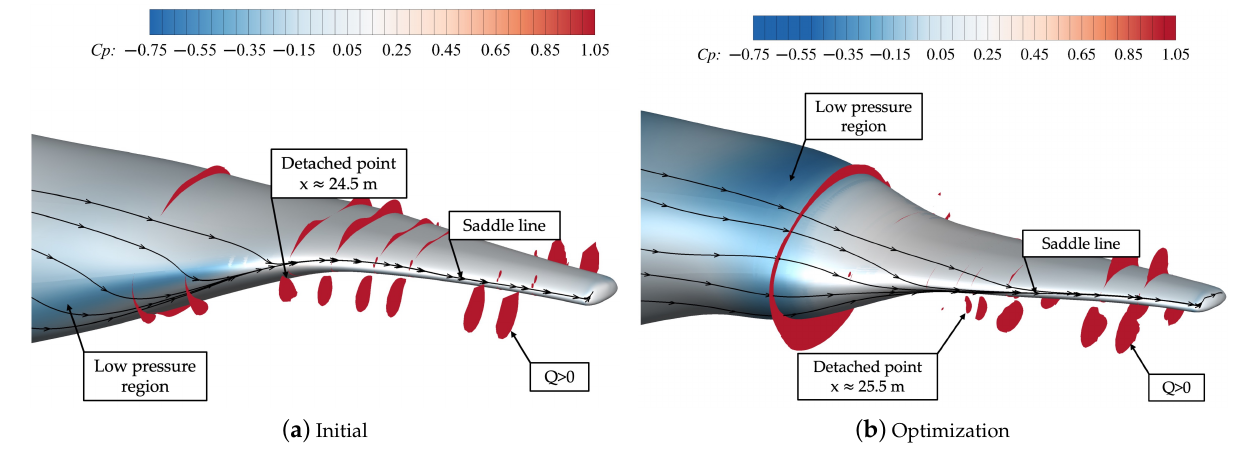
Figure 16. Comparison of surface and volume flow field.